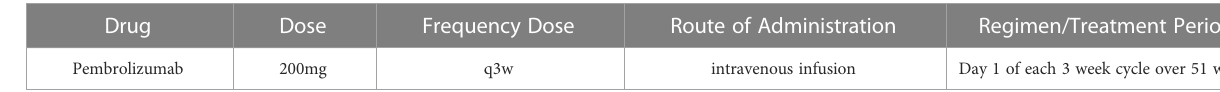
TABLE 3 Pembrolizumab